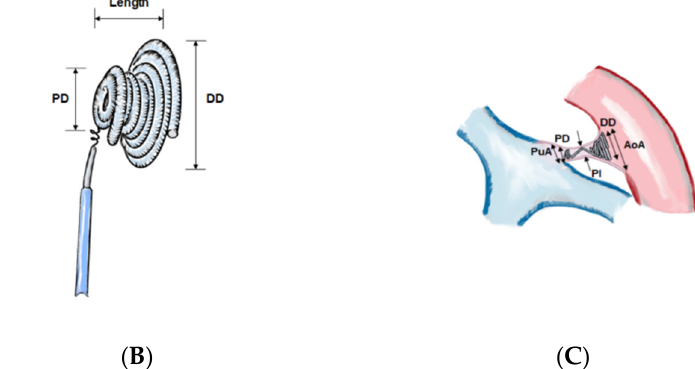
Figure 2. Illustration of the size relationships between regions of PDA and Nit ‐ Occlud ® Coils (NOC). The schematic illustration of ( A ) the regions of PDA, ( B ) the regions of NOC, and ( C ) the installed coil inside PDA. PuA; pulmonary ampulla of PDA, AoA; aortic ampulla of PDA, PI; PDA isthmus, PDA; patent ductus arteriosus, PD; proximal diameter of NOC, NOC; Nit ‐ Occlud ® coil, DD; distal diameter of NOC .